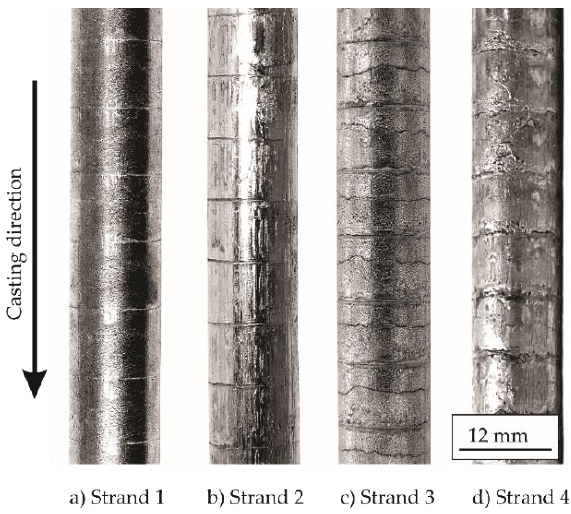
Figure 1. Macro photographs of the strands. ( a ) Strand 1; ( b ) strand 2; ( c ) strand 3, ( d ) strand 4.